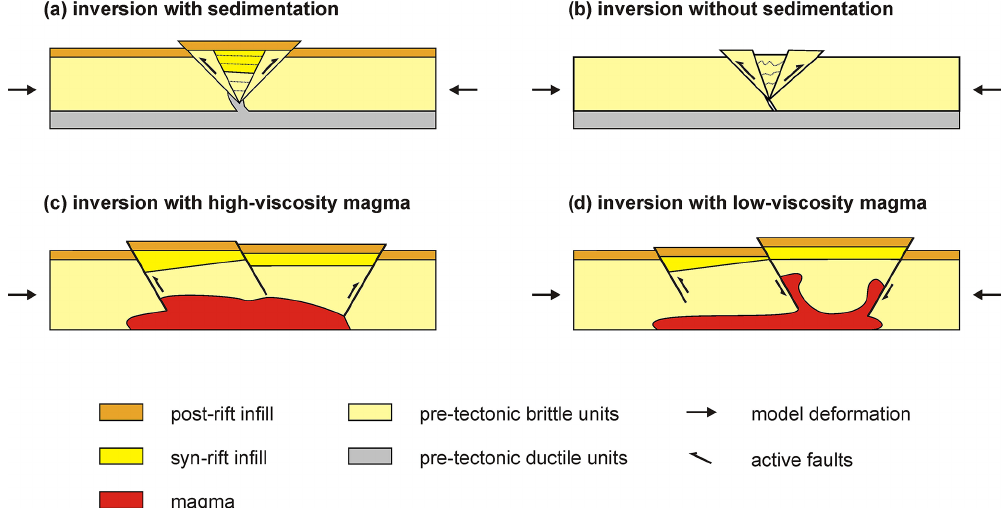
Figure 17. Influence of additional geological processes on basin inversion. (a–b) Effect of presence and absence of syn-rift sedimentation during rifting (inspired by Richetti et al., 2022). (c–d) Effect of magmatism and magma viscosity on inversion. Inspired by Martínez et al.